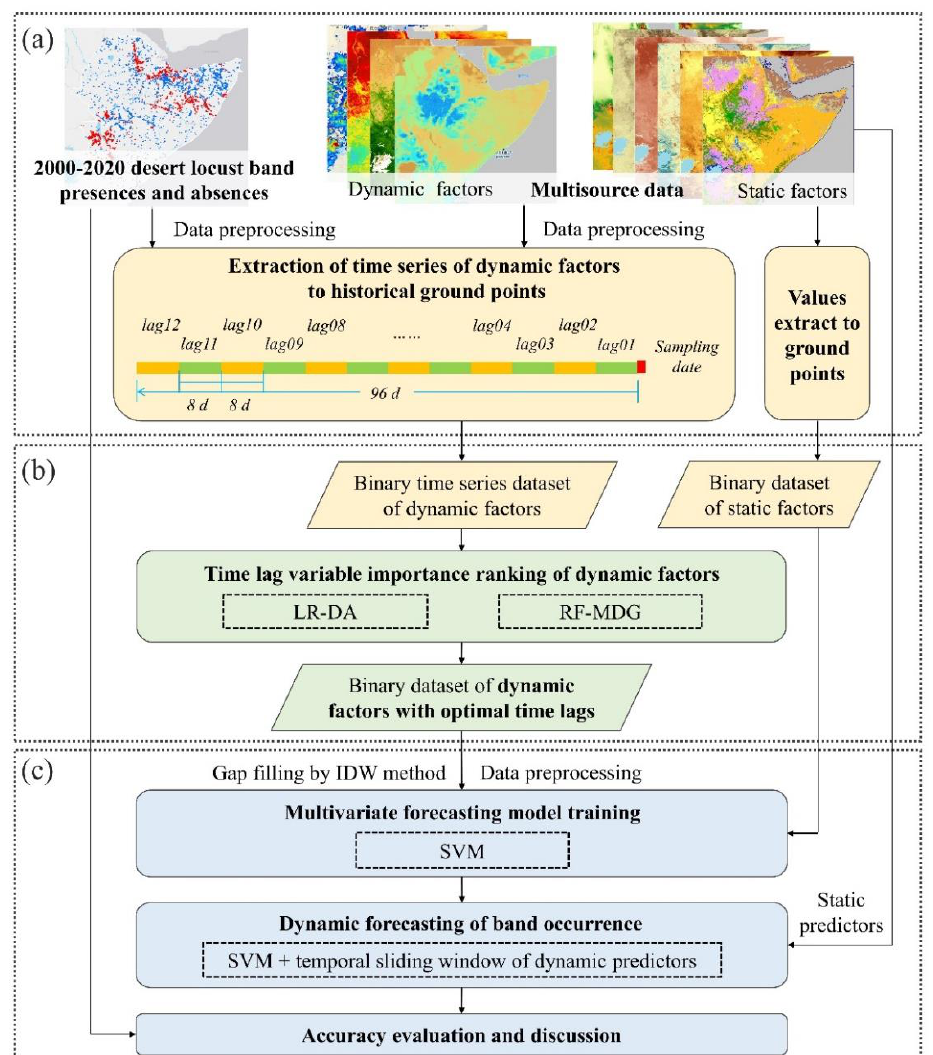
Figure 2. Methods and process. ( a ) Extraction of dynamic and static indicators of desert locust presence. ( b ) Time lag variable importance ranking for dynamic indicators. ( c ) Forecast of desert locust presence based on multivariate machine learning model with a temporal sliding window.